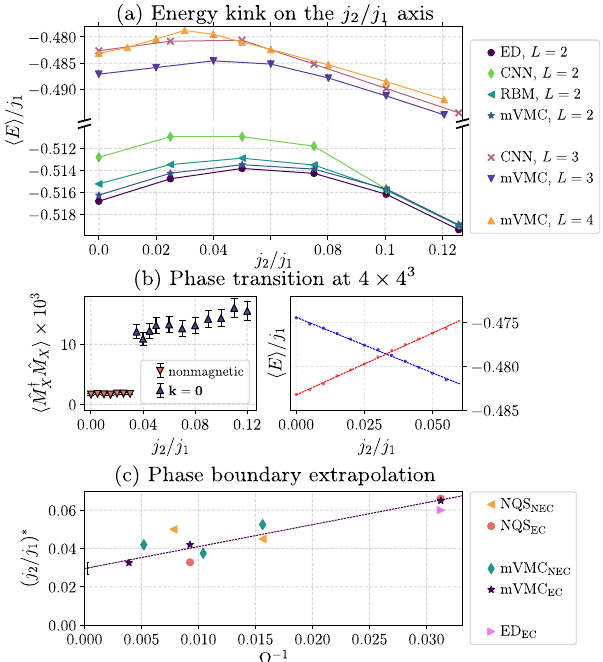
FIG. 2. Phase transition at the SU ð 2 Þ -symmetric point and its extrapolation to the thermodynamic limit. (a) Ground-state energy on 4 × L 3 clusters obtained within the various methods. (b) Left panel: magnetic susceptibility at k ¼ X as a function of =j j 2 1 within the hysteresis optimization performed at the cluster within mVMC. Right panel: energy-level crossing ob- tained using the hysteresis optimization. (c) Position of the phase boundary ð j 2 =j 1 Þ (cid:3) for EC or NEC as a function of inverse cluster size. The ED point corresponds to the position of the energy maximum. The dashed line is the linear fit over mVMC The error bar at Ω − 1 ¼ 0 is conservatively estimated as the difference between extrapolation and the measured transition point at the 4 × 4 4 cluster within mVMC.